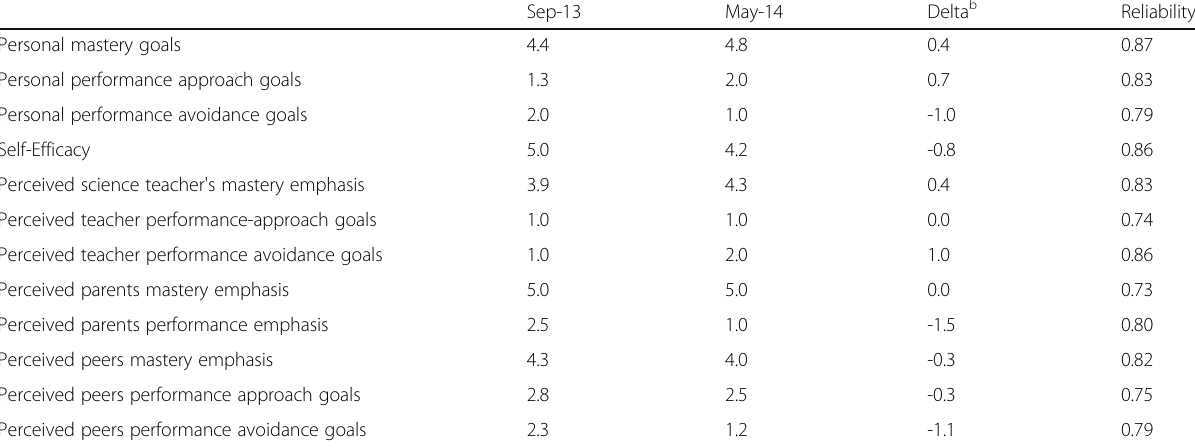
Table 1 Neta's Motivation Questionnaire Scores